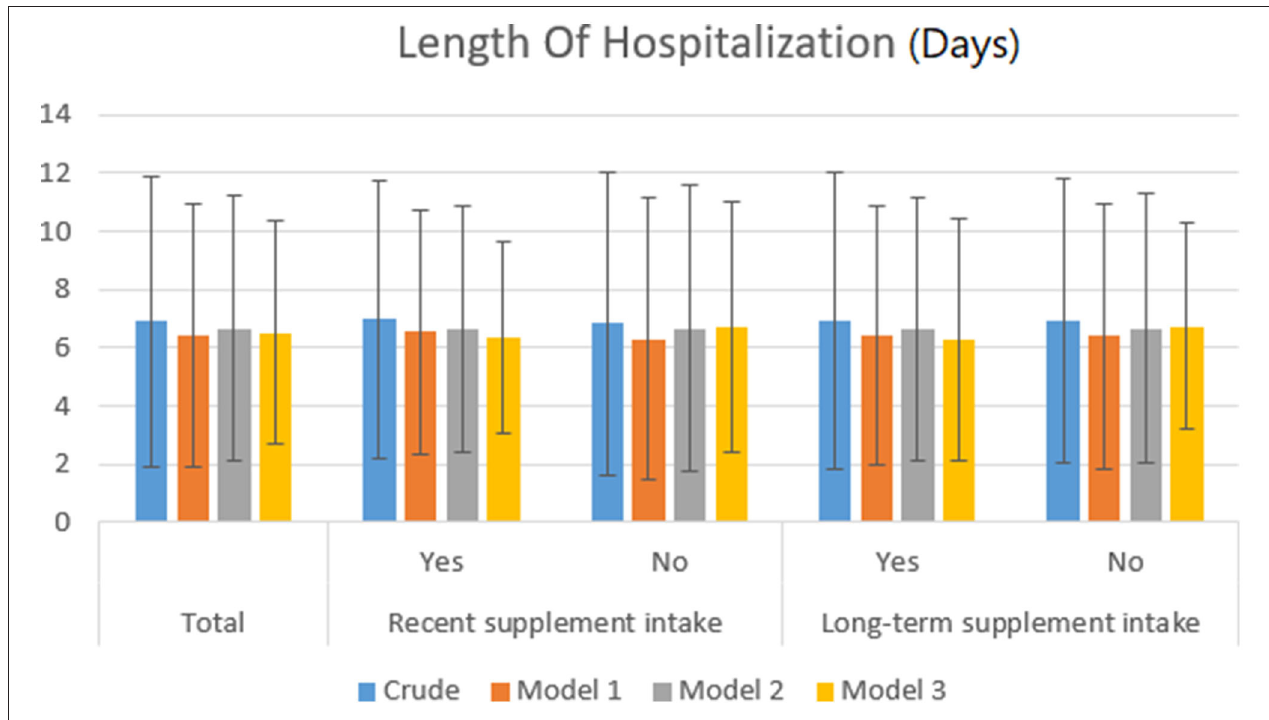
FIGURE 1 | Length of hospitalization in different supplement intake